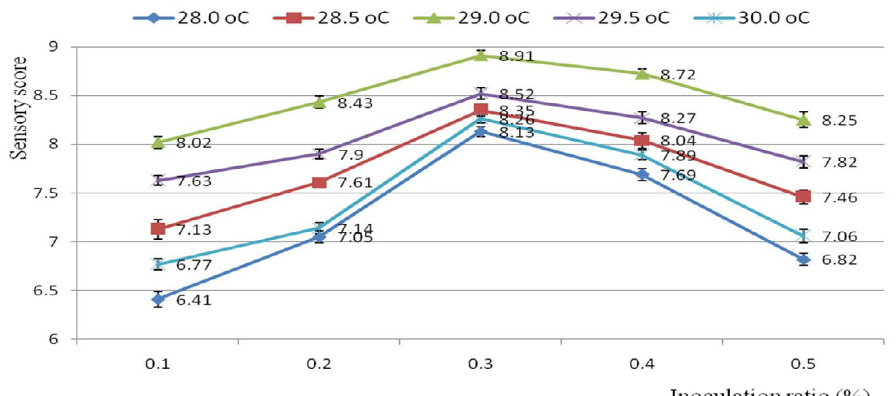
Fig. 1. Overall acceptance of the pickled shrimp affected by inoculation ratio (%) of Latilactobacillus curvatus (9 log cfu/ml) and fermentation temperature (°C) after 6 weeks of